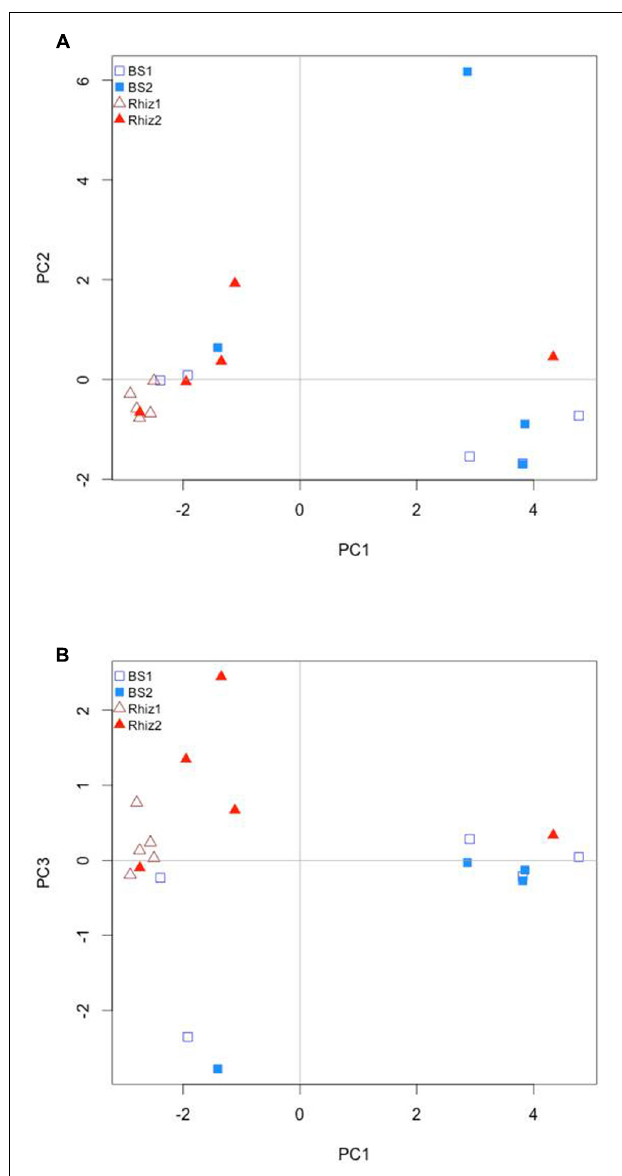
FIGURE 7 | Comparison by principal component analysis of the ecological distance (Bray–Curtis) of the different compartments (bulk soil, rhizosphere soil) and the different harvest time (flowering and early fruit development) of V. vinifera cv. Pinot Noir: (A) axis 1 vs. axis 2; (B) axis 2 vs. axis